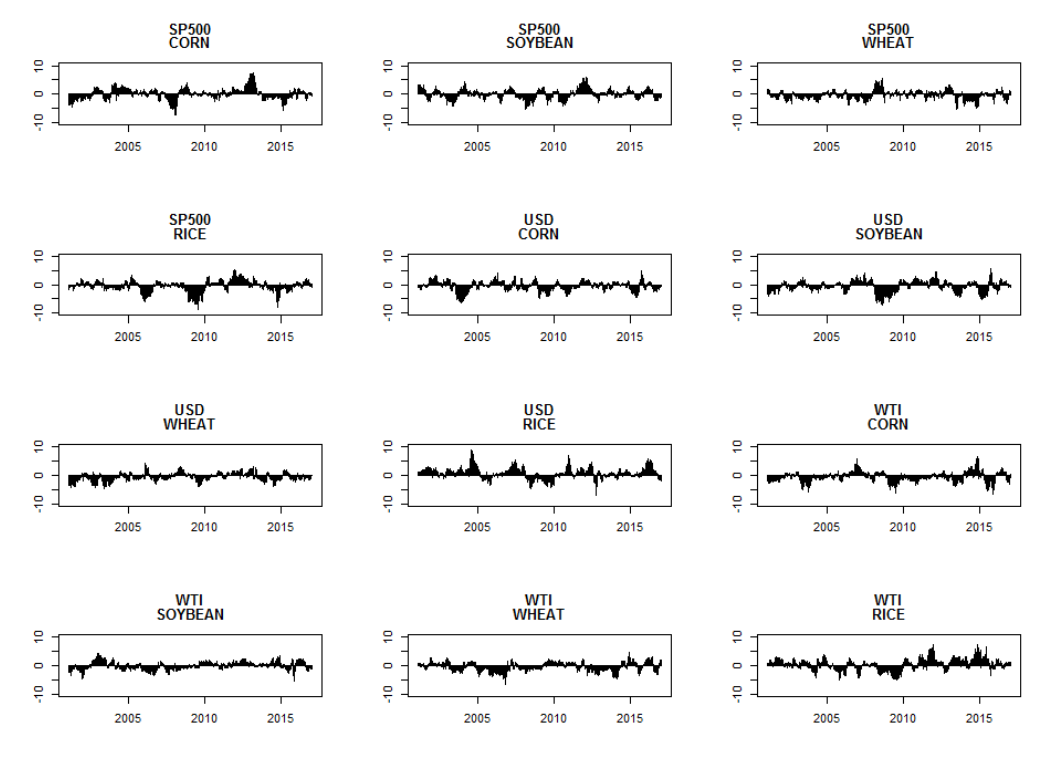
Figure 5A: Pairwise net volatility spillovers from the US stock (SP500), energy (WTI) and foreign exchange (USD) markets to the food markets (the OLS